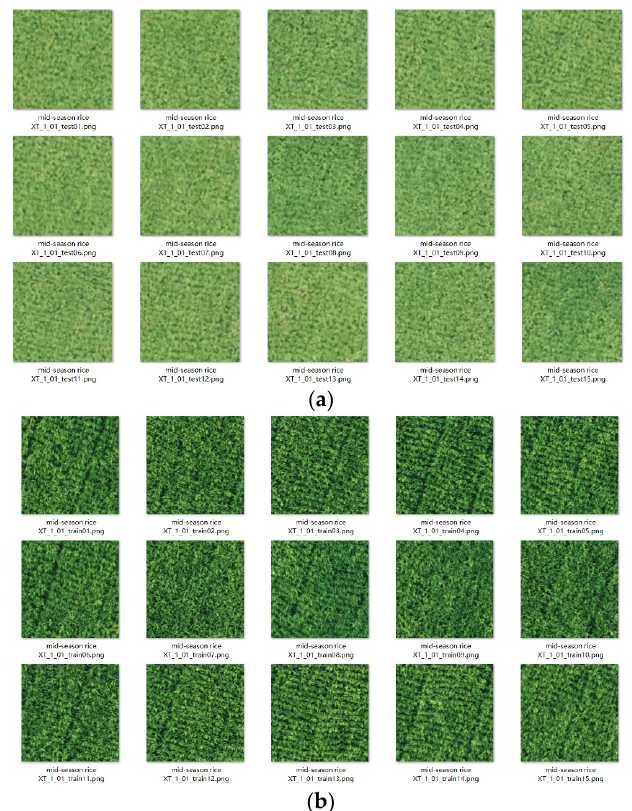
Figure 9. The samples for the training dataset and testing dataset from Xiantao in 2017: ( a ) 75% of images were acquired on 14 June for the training dataset; ( b ) 25% of images were acquired on 10 August for